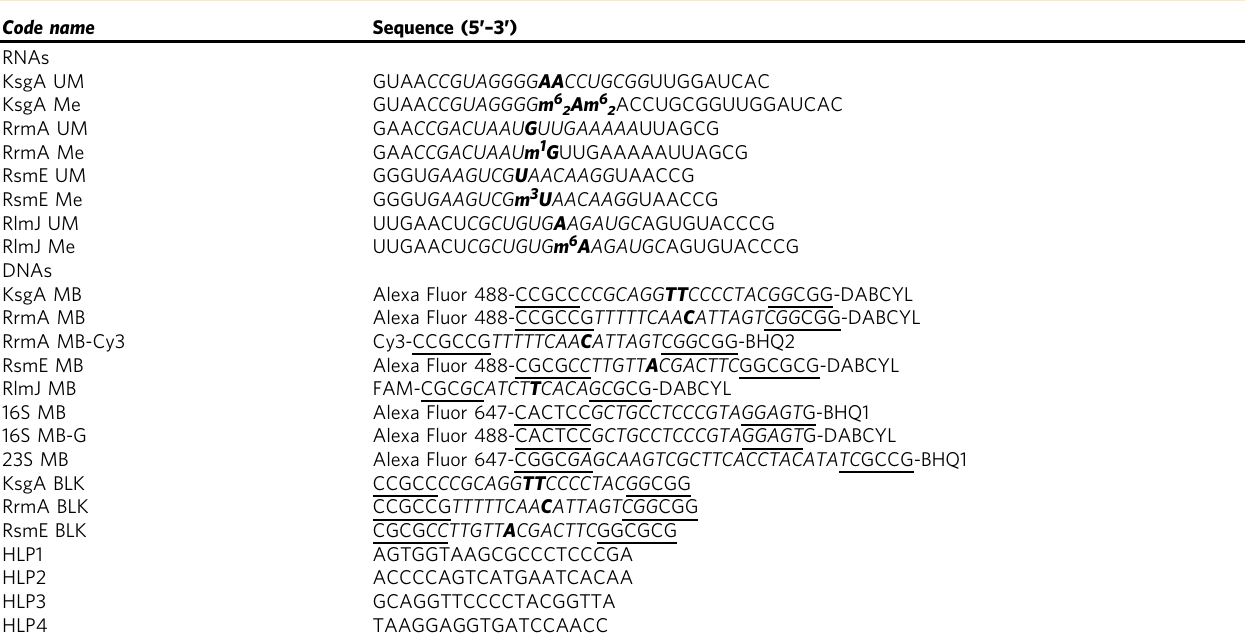
Table 1 Sequences of synthetic oligonucleotides Code name Sequence (5 ’– 3 ’ ) RNAs KsgA